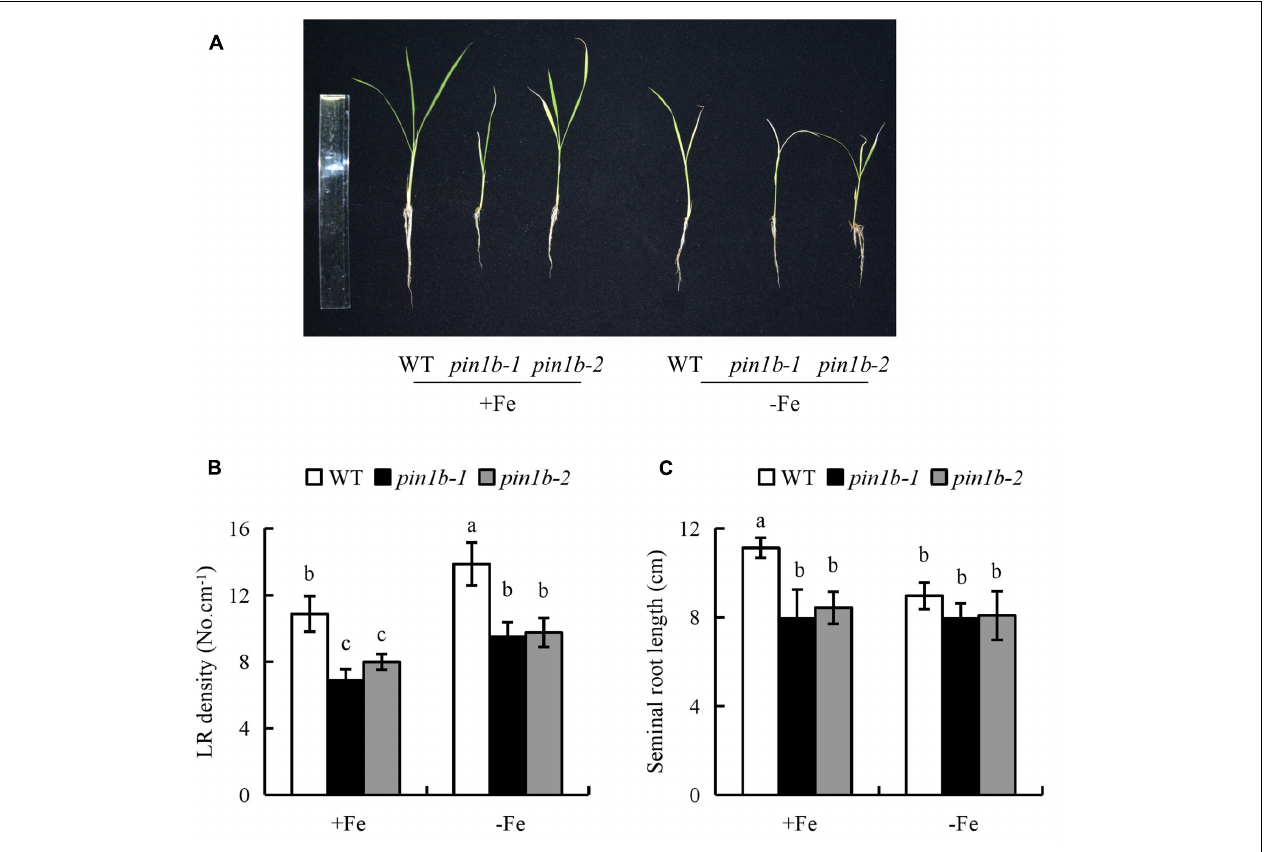
FIGURE 5 | The root morphology in wild-type (WT, Donjin) and ospin1b mutants. Seedlings were grown in hydroponic media − Fe (0 µ M) and +Fe (20 µ M) for 14 days. (A) The morphology of the rice plants; (B) LR density. (C) The length of seminal root. Data are means ± SE and bars with different letters indicate significant difference at P < 0.05 tested with